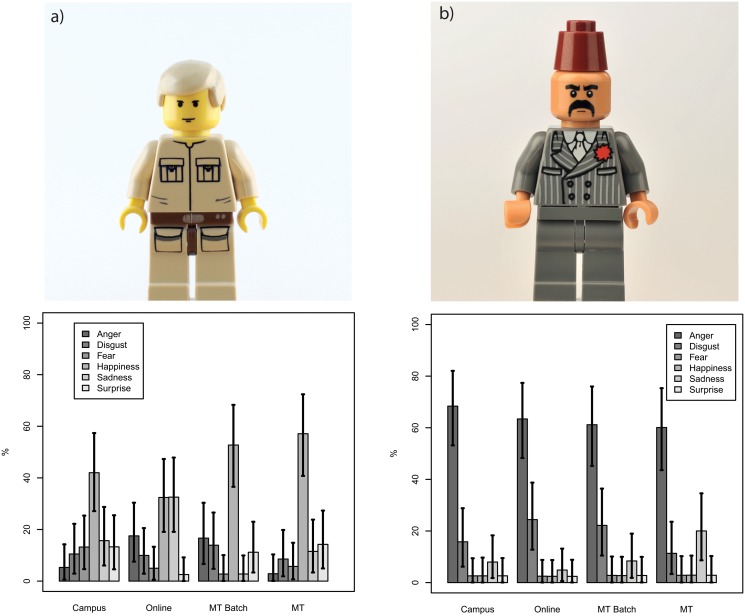
Frequencies of emotional categories for two Minifiguresa) Minifigure 03753 b) Minifigure 00948